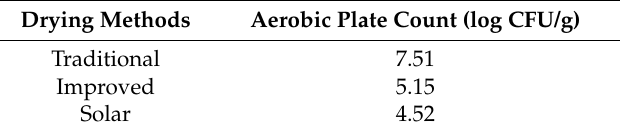
Table 3. Effect of the drying methods on microbial load (aerobic plate count (APC)) of H. molitrix.